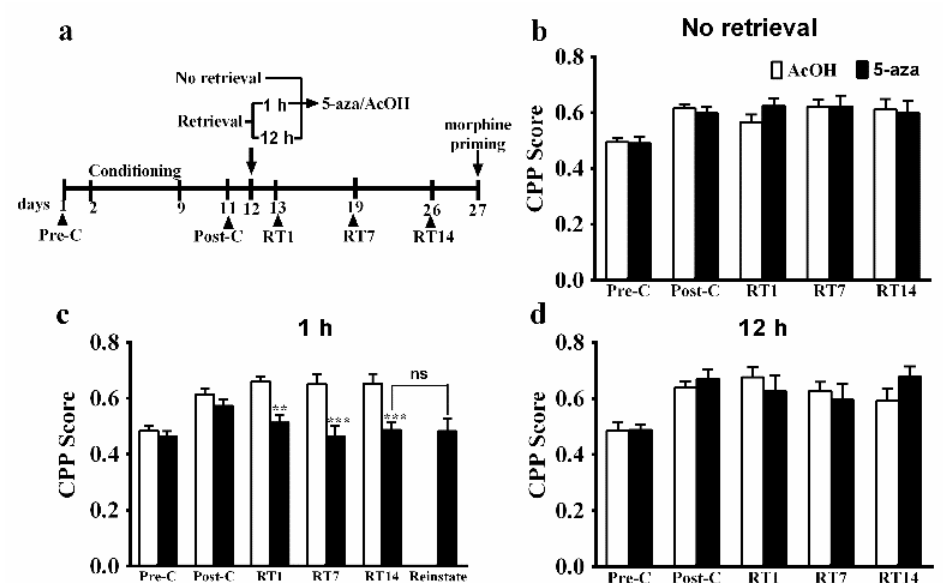
Figure 2. The effect of 5-aza on morphine reward memory reconsolidation was retrieval- and time-window-dependent. ( a ) Timeline of the experiment. ( b ) Infusion of 5-aza into the basolateral amygdala (BLA; 2 µg) had no effect on reconsolidation in the absence of retrieval ( n = 13). ( c ) Intra-BLA infusion of 5-aza (2 µg) 1 h after memory retrieval blocked reconsolidation ( n = 9–12). ( d ) Injection of 5-aza into the BLA at 12 h after retrieval did not affect reconsolidation ( n = 7–8). Data are expressed as the mean ± SEM of preference scores. ** p < 0.01, *** p < 0.001, compared to AcOH at the same time-point. ns: not significant.